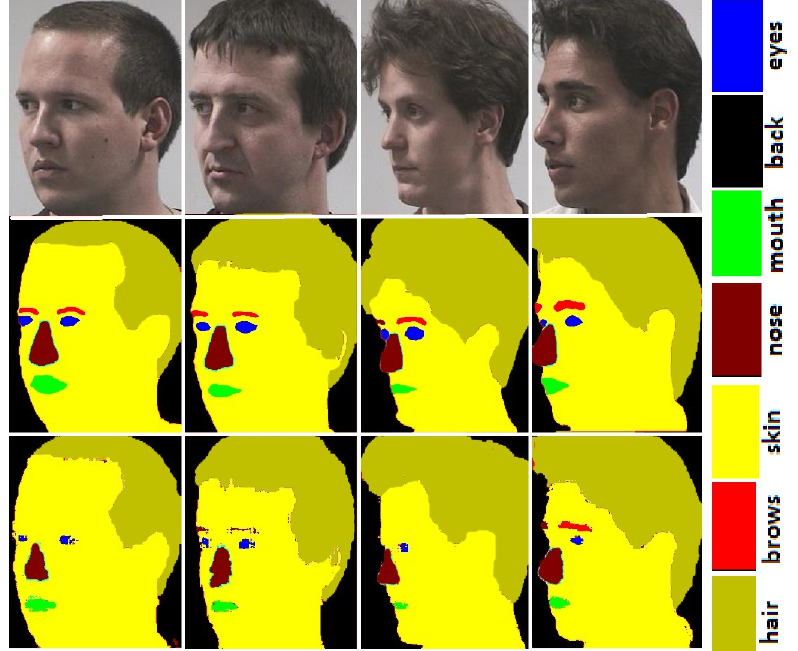
Figure 2. Face segmentation results for profile images for FASSEG [29] database. Order of the images, row 1 shows: original images, row 2: ground truth, and row 3: face parsing